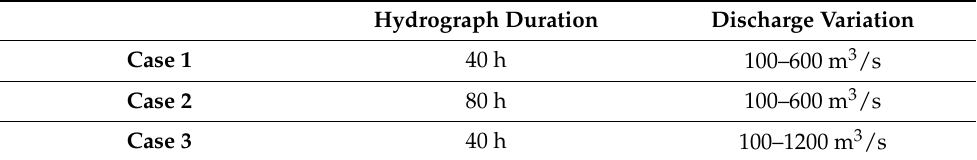
Table 1. Hydrograph duration and variation in the numerical